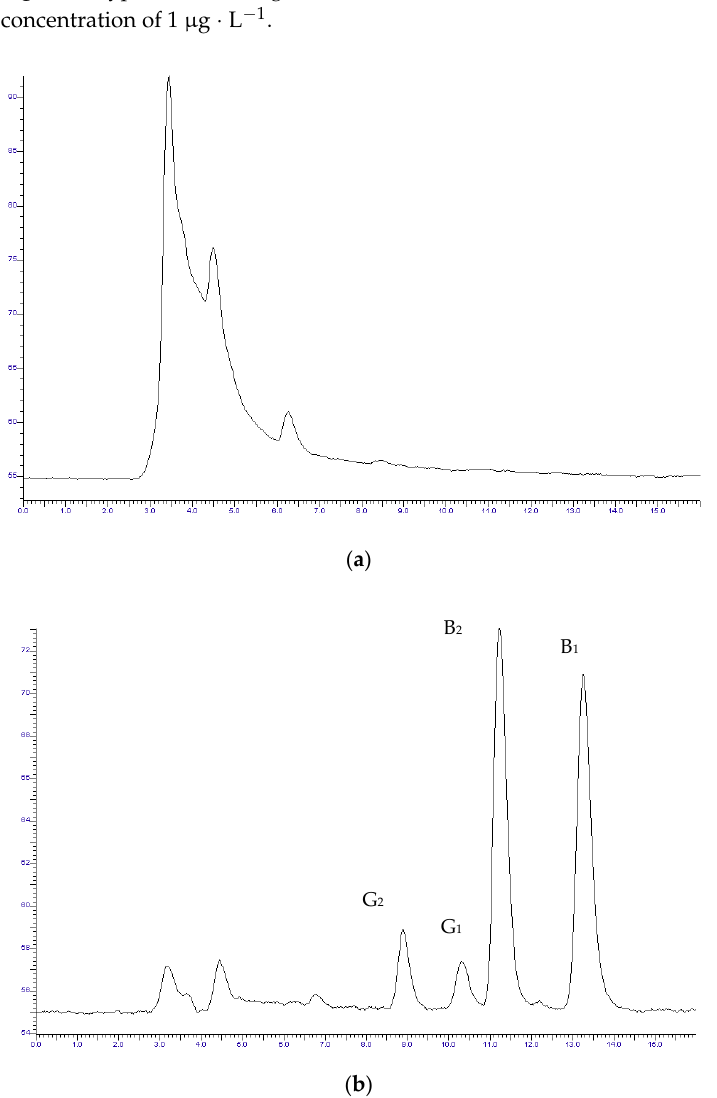
Figure 3. Chromatogram of (a) blank feed sample and (b) spiked sample at a concentration of 4 μg × kg −1 for all the examined compounds (G 2 , G 1 , B 2 , B 1 ).